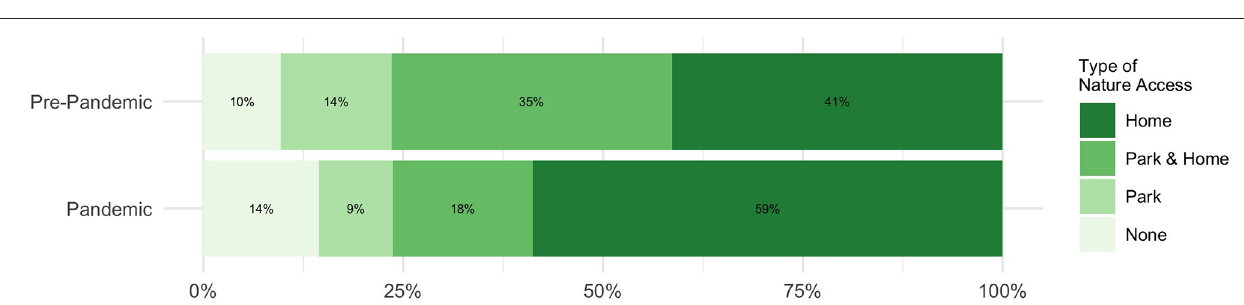
spend time in nature (Income diff = 15.0 percentage points; Race diff = 7.7 percentage points) or to have spent time just in public nature areas (Income diff = 5.2 percentage points; Race diff = 6.5 percentage points). They were also less likely to report having spent time in a private yard (Income diff = − 8.5 percentage points; Race = − 8.7 percentage points) diff or both a private yard and public nature areas (Income diff = − 11.6 percentage points; Race = − 5.4 percentage points; diff Supplementary Table 5